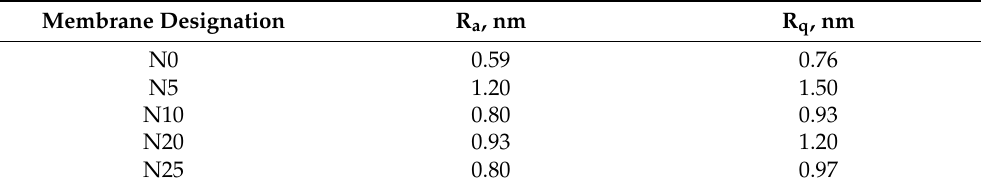
Figure 3. AFM images of selective layer surface of TFC PVA/PAN membrane (N0) and PVA-TFN Al 2 O 3 ·SiO 2 /PAN membranes (N5, N10, N20, N25). Table 2. The roughness parameters of selective layer surface of TFC PVA/PAN membrane and TFN PVA-Al 2 O 3 · SiO 2 /PAN